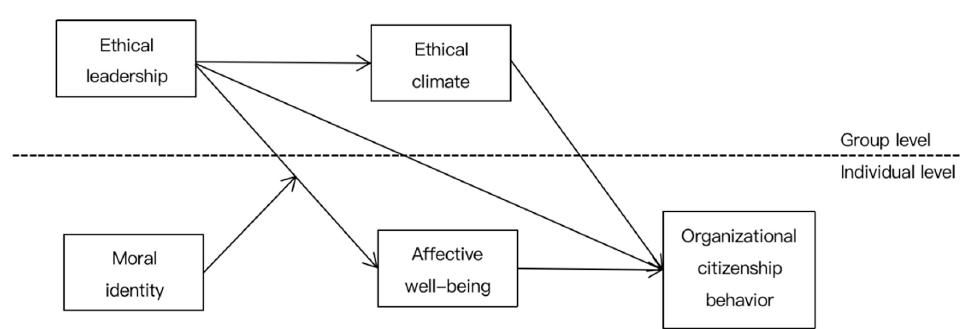
Figure 1. Research